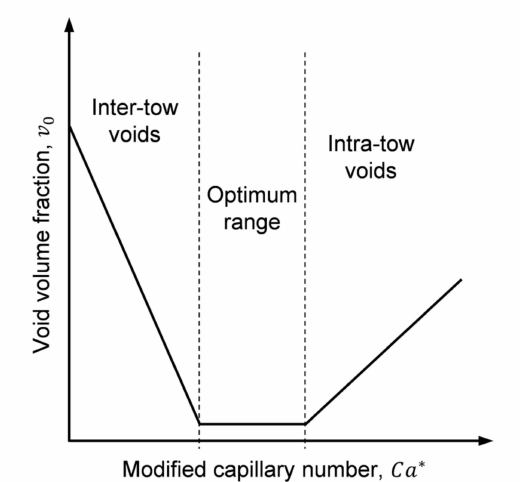
Figure 4. Void formation due to resin flow through heterogeneous dual-scale porous media. Resin viscosity, µ , is a function of temperature and time elapsed from the onset of the reaction of polymerization. As the reaction progresses, the degree of crosslinking increases, involving a continuous raise in µ and making it more difficult for the resin to flow through the preform. Initially, the crosslinking reaction advances slowly; but large variations in reaction times may cause substantial changes in µ . Not all degassing procedures took the same time; hence, although resin was kept at ambient temperature, T amb , flow differences could arise due to different values of µ during preform filling. In spite of not directly monitoring µ along the VI process, times elapsed from resin mixing until the onset of the filling stage, t 0 → fill , and until the end of the filling stage, t 0 → fill , were recorded to 0 end account for the effects caused by µ